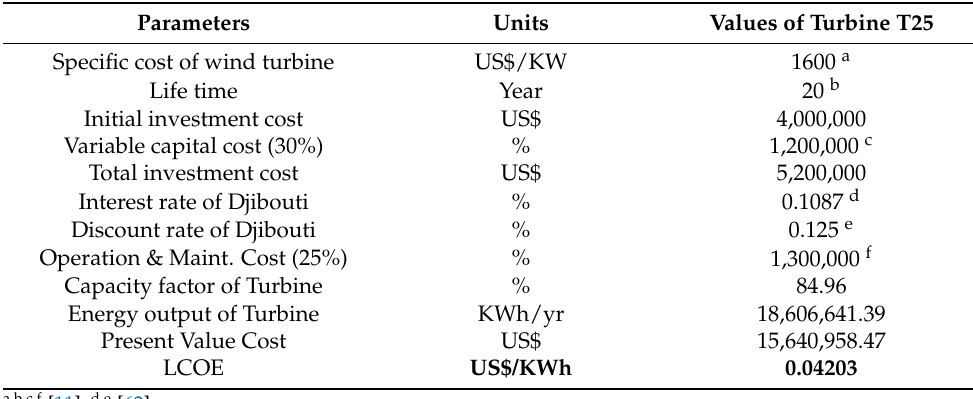
Table 2. Unit cost of electricity generated by Turbine “Yinhe